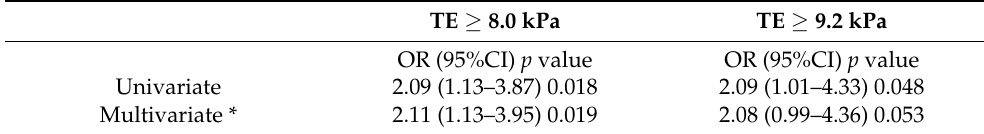
Table 5. Analysis of risk of liver fibrosis using different transient elastography cut-offs as dependent variables, in low-normal thyroid function (TSH 2.5–4.94 µ IU/mL) vs. strict-normal thyroid function (TSH < 2.5 µ IU/mL). Logistic regression models.